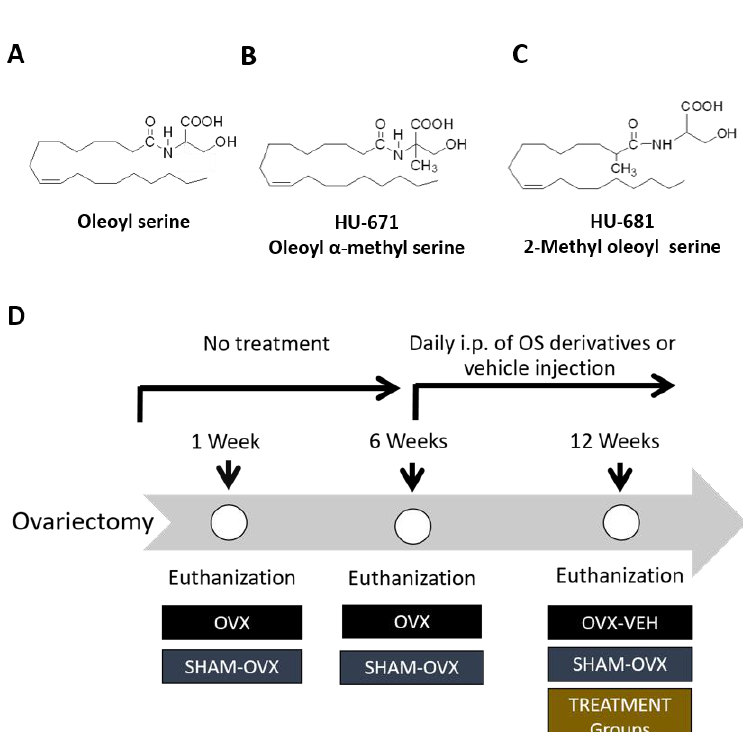
Figure 1. Experimental design to test the efficacy of methylated OS derivatives in a rescue model for osteoporosis. The chemical structure of OS ( A ) and its methylated derivatives, oleoyl α -methyl serine (HU-671) ( B ), and 2-methyl oleoyl serine (HU-681) ( C ). Schematic representation of the experimental design for testing the rescue of bone loss by OS, HU-671 and HU-681; 8 week-old female mice were either OVXed or sham-OVXed and analyzed one week, and 6 weeks after surgery to serve as controls. 6 weeks post operation, daily intraperitoneal treatment with Vehicle, OS, HU-671, or HU-681 was initiated for an additional 6 weeks ( D ).